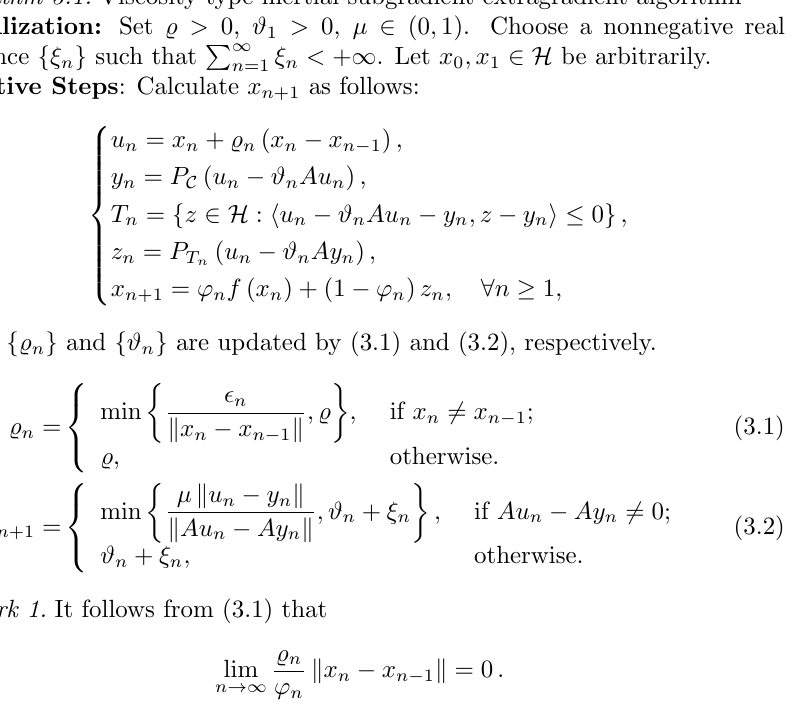
Algorithm 3.1. Viscosity-type inertial subgradient extragradient